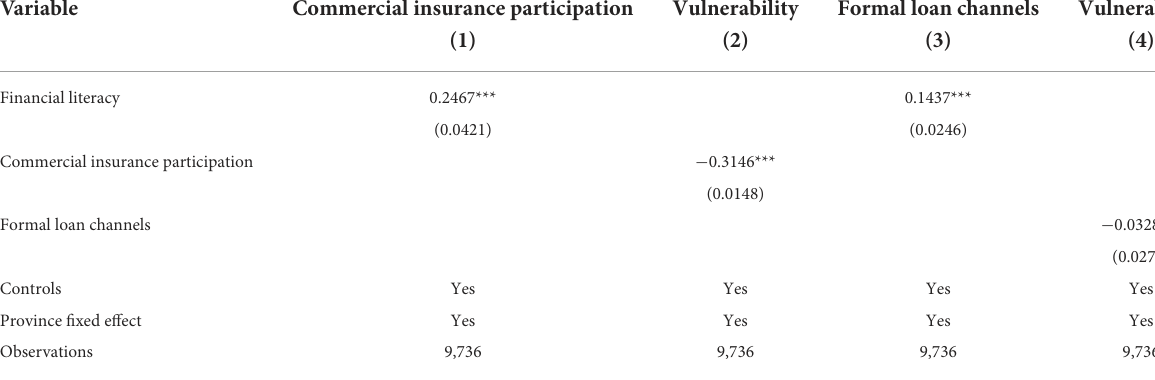
TABLE 9 Test on the impact mechanism of financial literacy on relative poverty (2SLS estimation). Variable